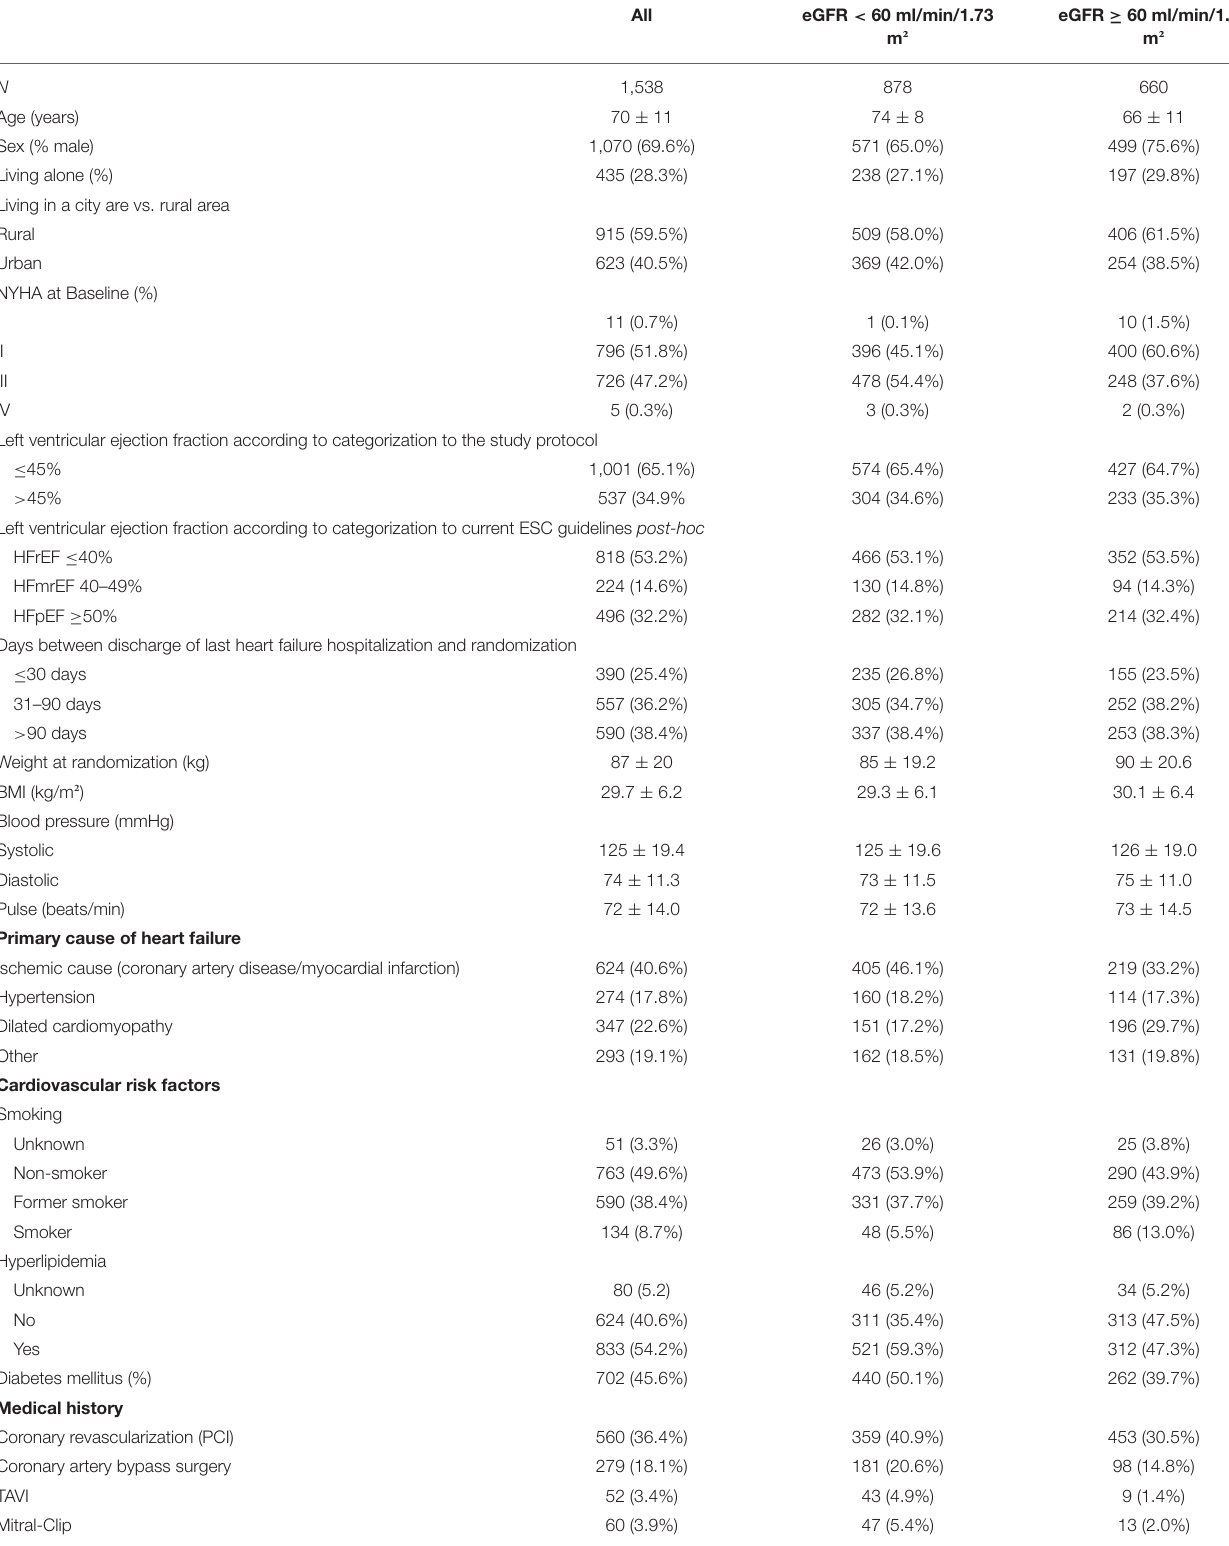
TABLE 2 | Demographics of the whole cohort, impaired (eGFR < 60 ml/min/1.73 m ² ), and normal (eGFR ≥ 60 ml/min/1.73 m ²